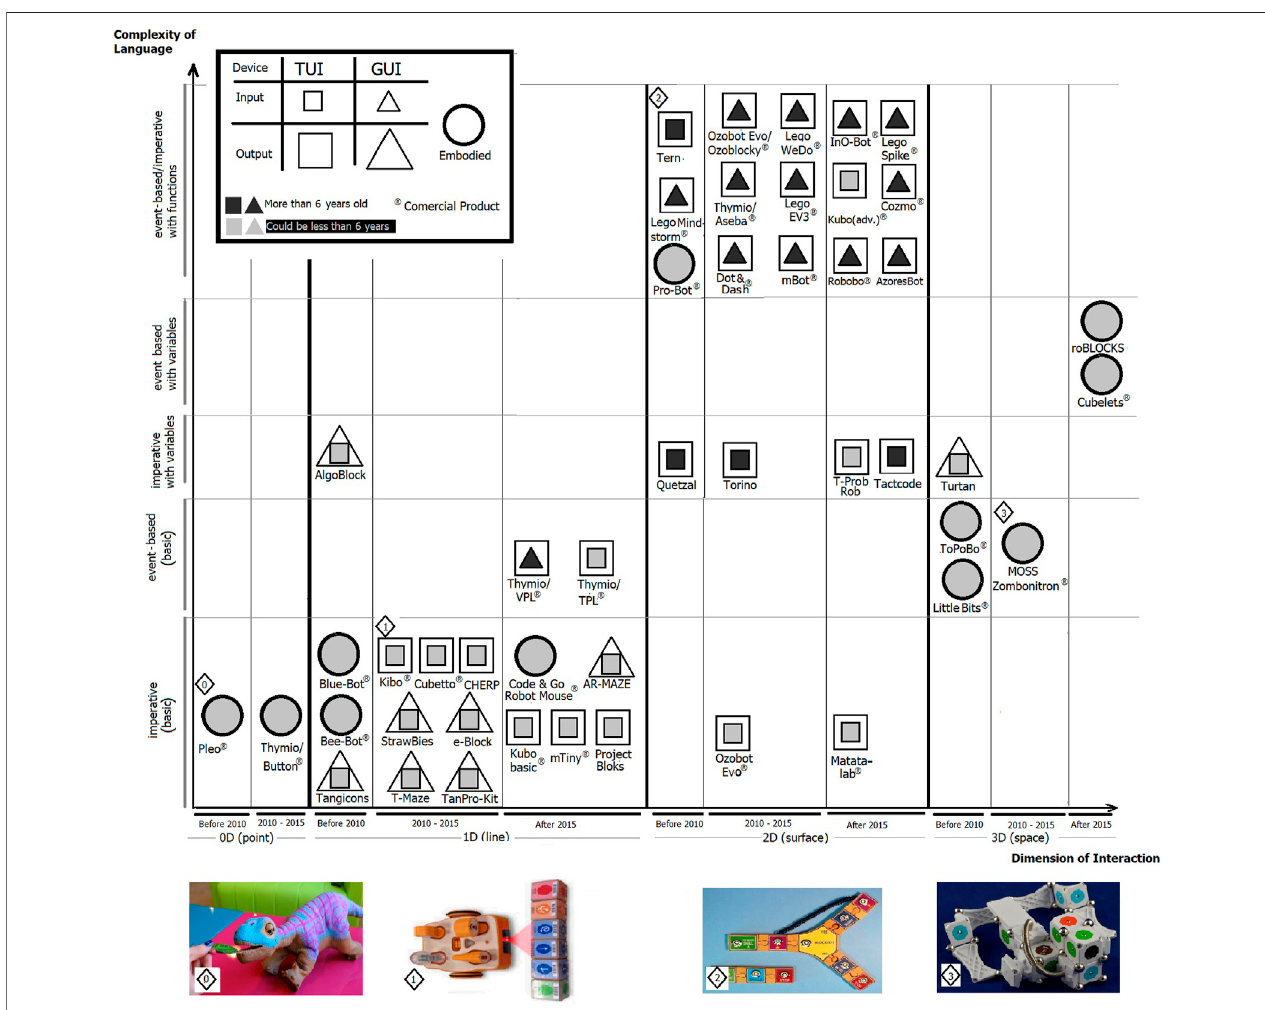
FIGURE 1 | Classi fi cation of the tangible solutions based on input versus output devices, the complexity of programming language used and the year of their release.Bellowthediagram, picturesfrom0to3depictTPLexamples,organized inthedifferentspacedimensions.Fromlefttoright, thedinosaurPleo(0)interacts with touch, the Kibo (1) reads a sequence of commands, the Tern (2) represents the code in a space con fi guration and, fi nally, MOSS (3) uses a 3D space language in a mix activity of programming and robot building.